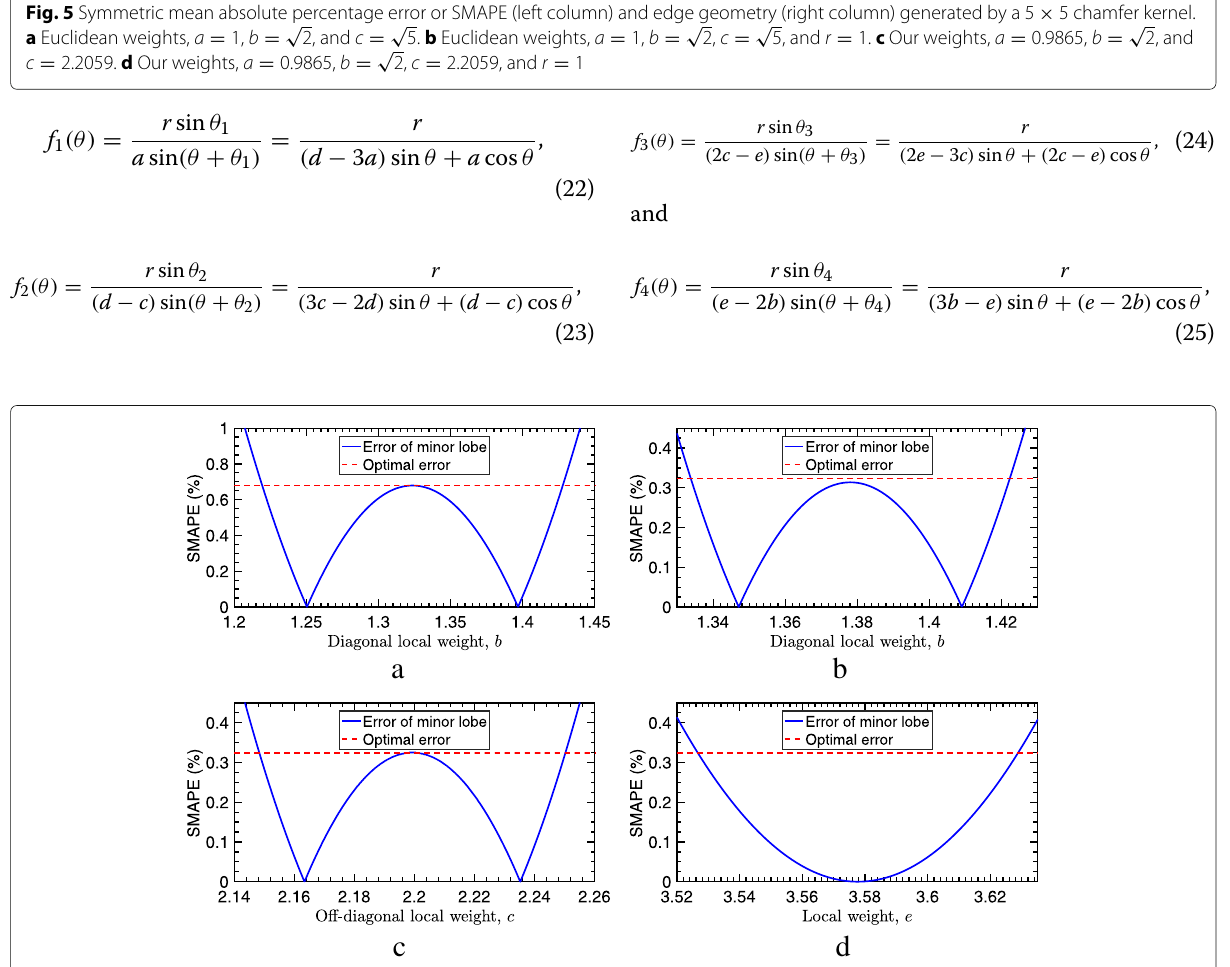
Fig. 6 Variation of symmetric mean absolute percentage error (SMAPE) with non-redundant local distances controlling minor lobes. a 5 × 5 kernel. √ b 7 × 7 kernel. c 7 × 7 kernel, e = 3.5830. d 7 × 7 Kernel, c =